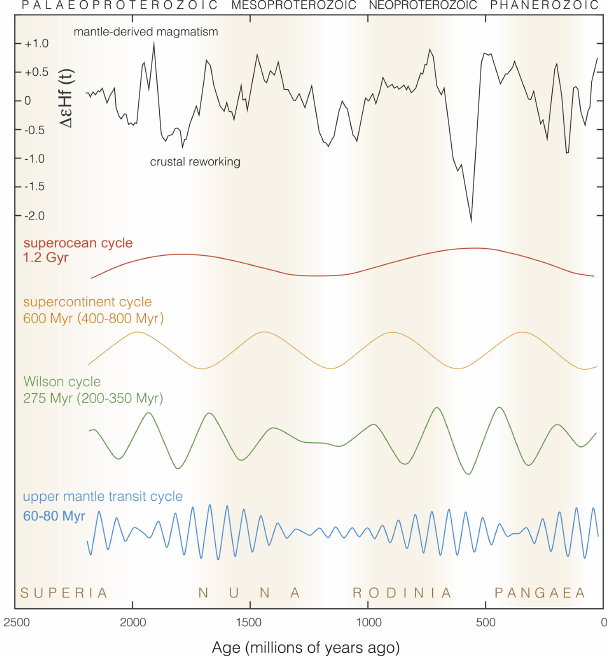
Figure 12. Global Hf database (black) and cycles determined by the time-series analysis: superocean cycle ( ∼ 1.2Gyr; red), the super- continent cycle ( ∼ 600Myr; yellow), the Wilson cycle ( ∼ 275Myr; green), and an upper mantle cycle ( ∼ 60–80Myr;